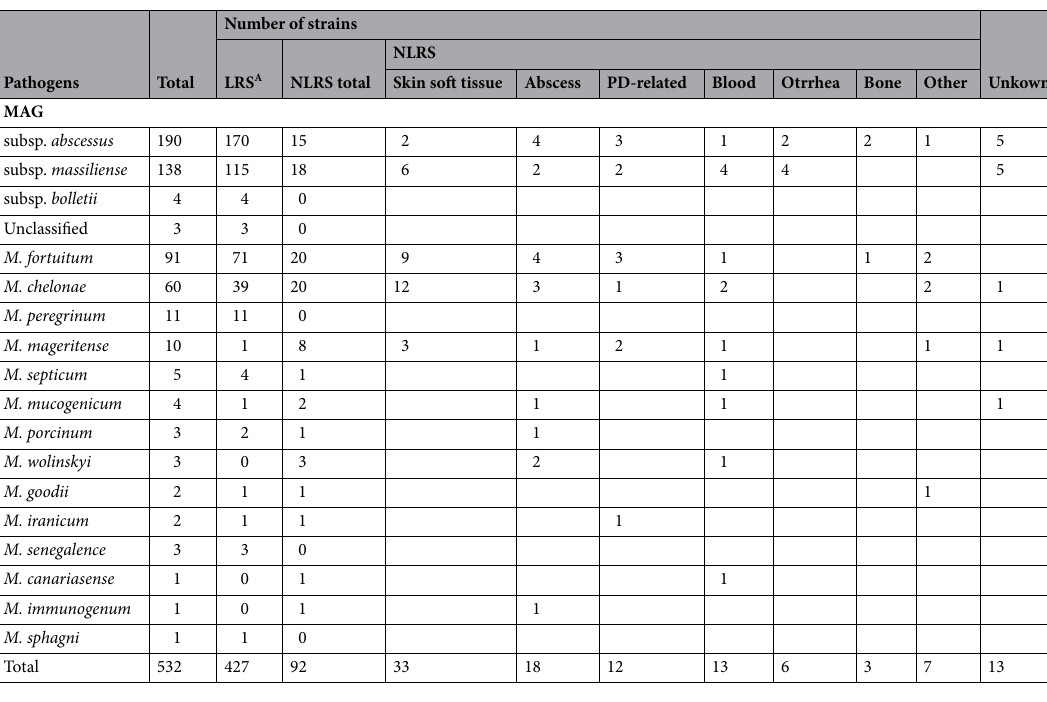
Table 1. Distribution of rapidly growing mycobacteria species by specimen type. PD peritoneal dialysis. A LRS contained 423 sputum and 4 bronchoalveolar lavage fluid samples.